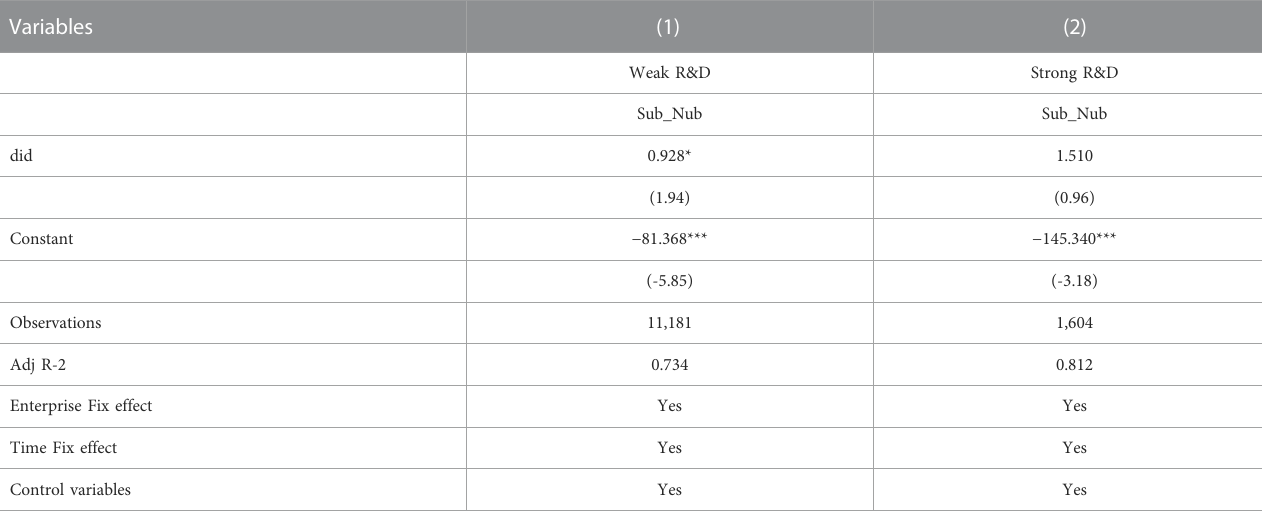
TABLE 5 Corporate R&D capabilities.